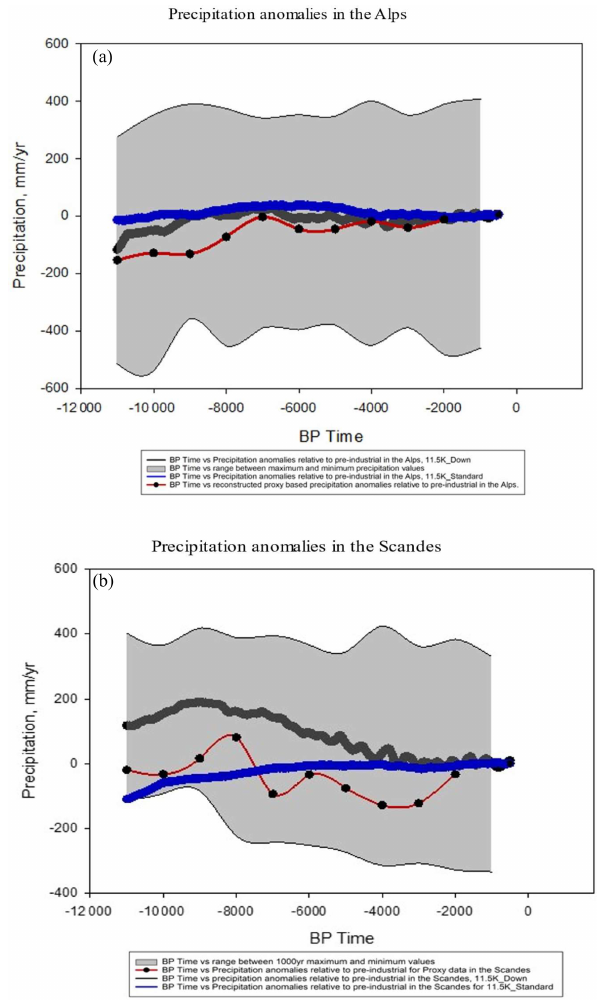
Figure 7. Comparison between simulated annual precipitation anomalies from iLOVECLIM and pollen-based reconstructions from Mauri et al. (2015) in the Alps (a) and the Scandes moun- tains (b) . The red line shows proxy reconstructions, while the blue and black lines show the standard and downscaling simulations, re- spectively. Grey-shaded areas represent the range between the max- imum and minimum precipitation values in the simulations, and the black curve shows the 1000-year running mean of precipitation anomalies relative to the pre-industrial era (in mmyr − 1